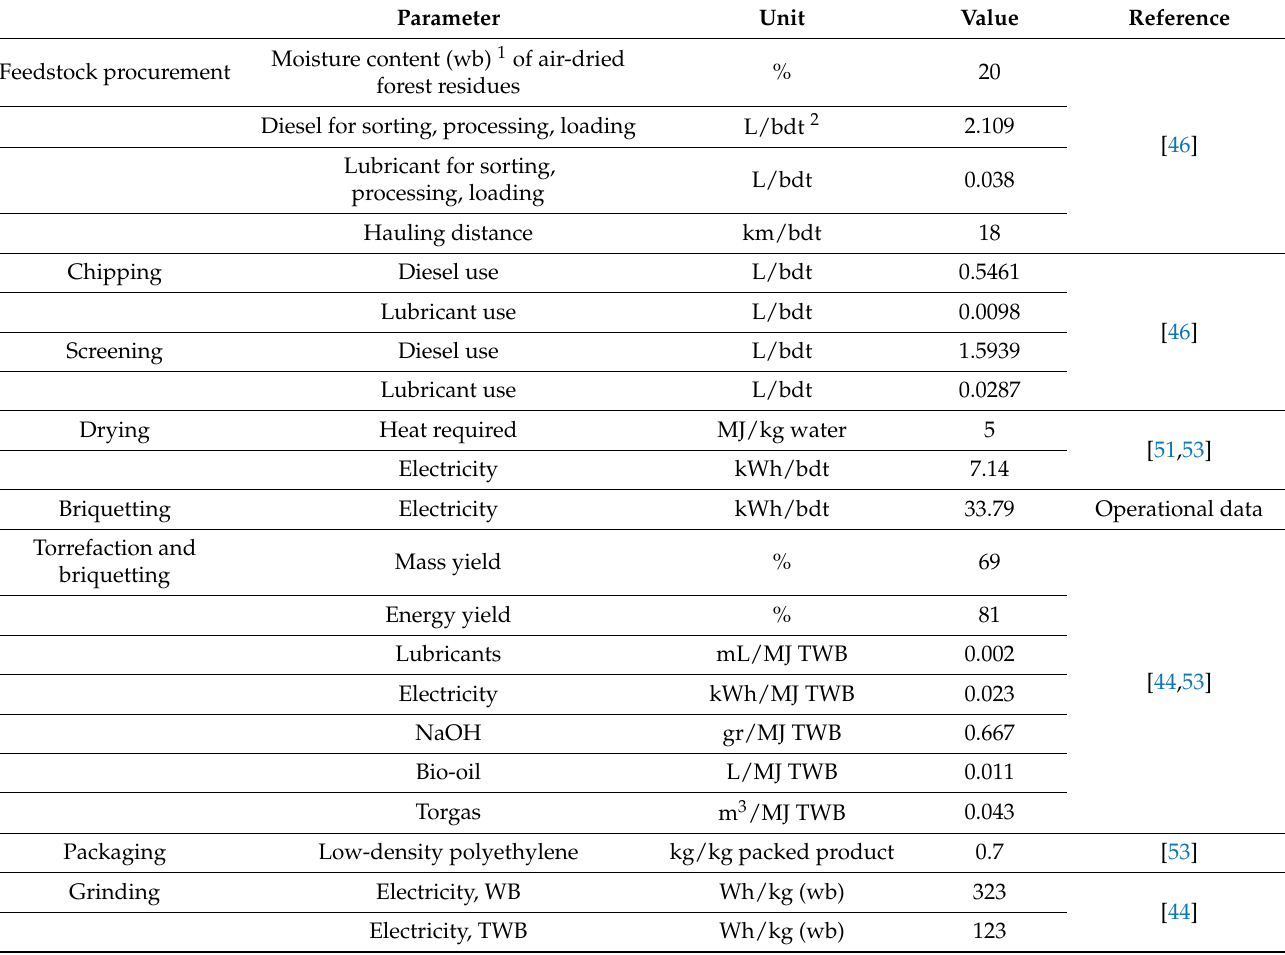
Table 3. Data summary for modeling the wood briquette (WB) and torrefied wood briquette (TWB) supply